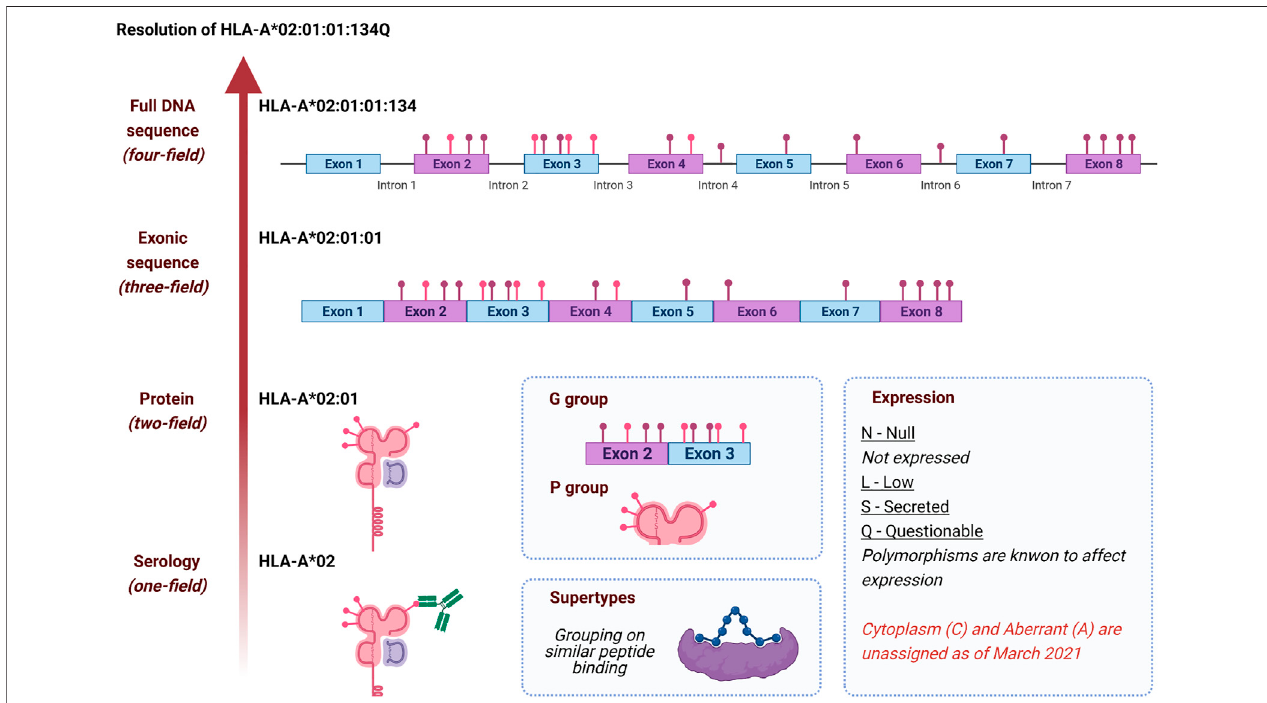
FIGURE 1| History and developmentof HLA nomenclature as illustrated by HLA-A*02:01:01:134Q. Each level ofresolution corresponds to agroup of HLA alleles fi tting the description, except for the full DNA sequence, a unique HLA allele. Colored pins represent non-synonymous polymorphism (pink) and synonymous or intronic polymorphisms(purple);thedisplayedpolymorphismisonlyindicativeanddoesnotre fl ect HLA-A*02:01:01:134Q sequence.PandGgroupsarenamedwiththelowest numbered two- fi eld (HLA-A*02:01)and three- fi eld (HLA-A*02:01:01) HLAallelename, respectively. Class IIP and Ggroups are based on exon 2only, while class I PandGgroupsarebasedonexons2and3.Supertypesarenotde fi nedaspartoftheof fi cialnomenclature(WangandClaesson, 2014;delGuercioetal.,1995;Sidney et al., 1995). Created with